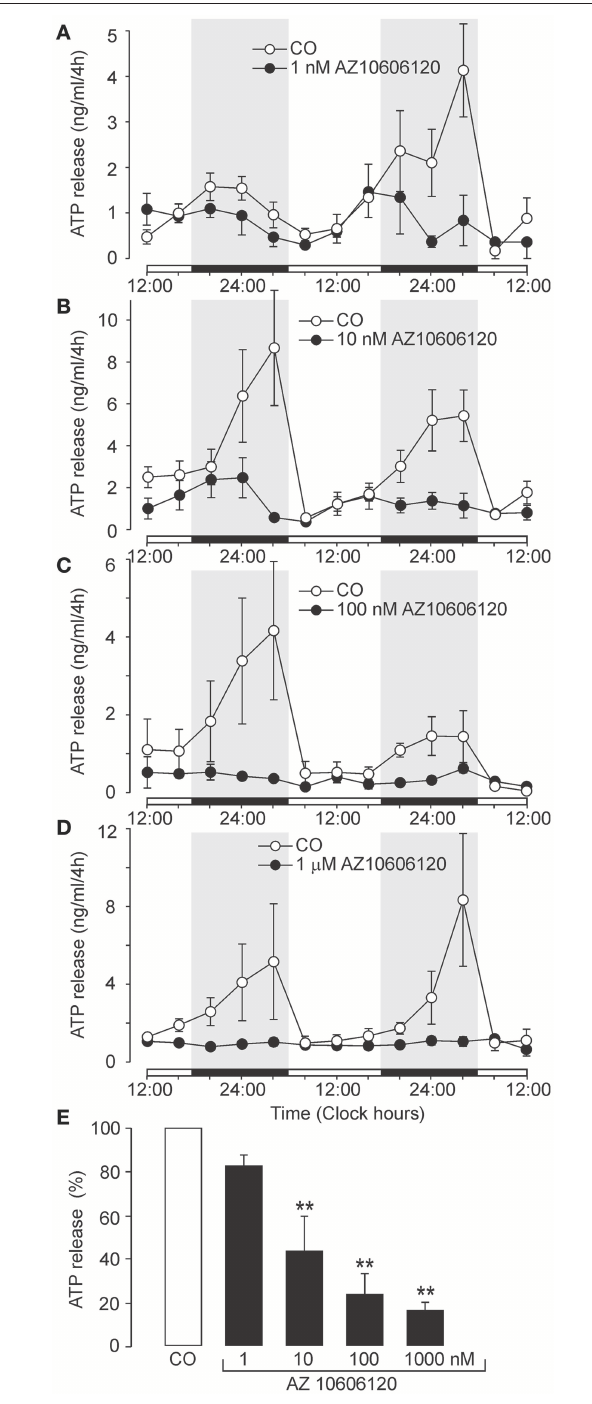
FIGURE 2 | Inhibition of circadian ATP release by the selective P2X7R blocker AZ10606120. (A–D) Examples of the ATP release rhythm in control cultures (open symbols) and cultures incubated with the P2X7R negative allosteric modulator AZ10606120 (closed symbols): 1nM (A) , 10nM (B) , 100 nM (C) , and 1 µ M (D) . Summary histogram comparing the effects of various concentrations of AZ10606120 on cumulated ATP release (E) . Data are presented as the means ± SEM of three to six experiments. ** P < 0.01 compared to the control.